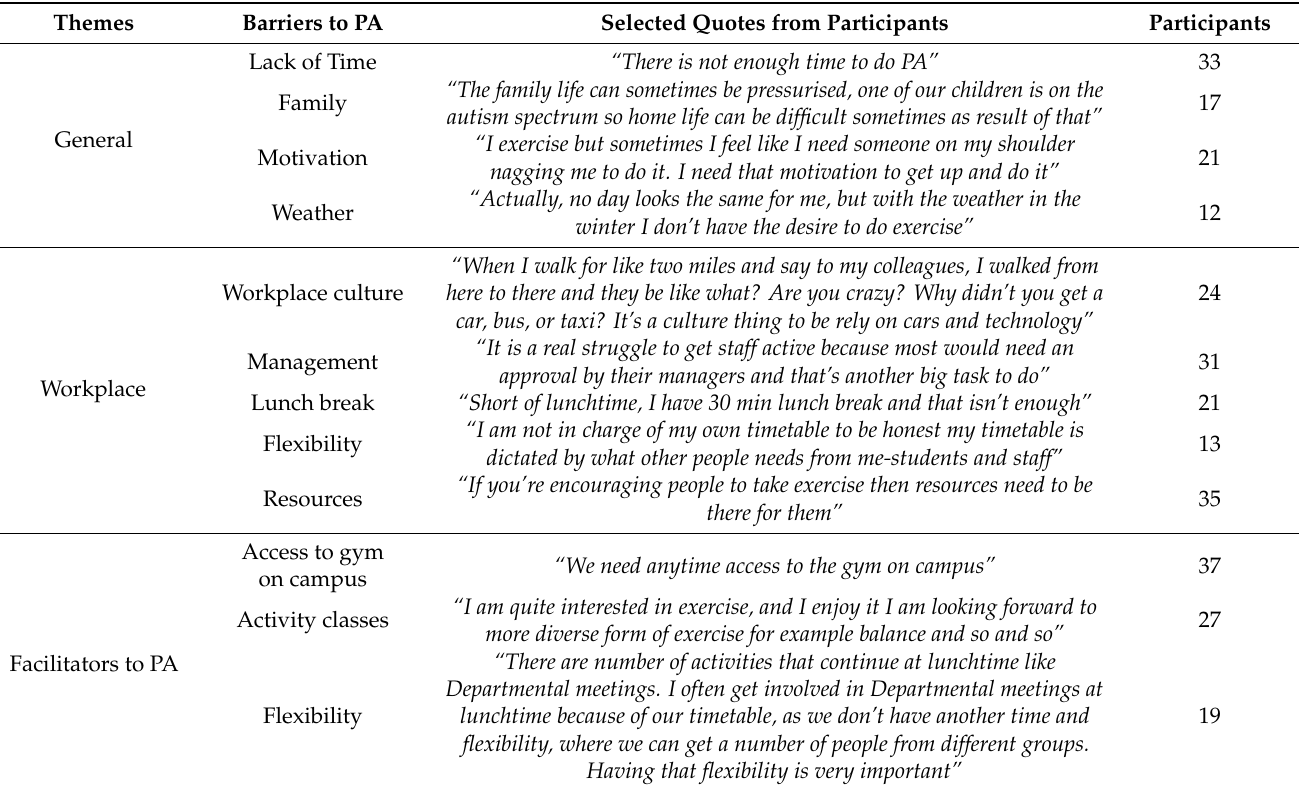
Table 2. A summary of themes and examples of raw data extracts for barriers to and facilitators for PA from active and inactive